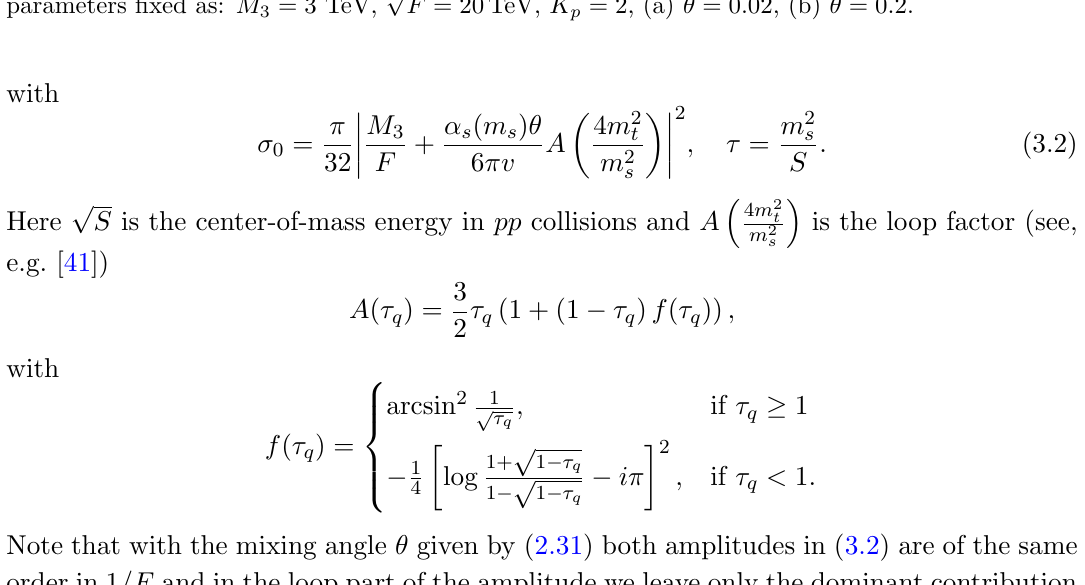
Figure 2. Sgoldstino production cross section for a set of total energies of protons p S , and model parameters (cid:12)xed as: M 3 = 3 TeV, p F = 20 TeV, K p = 2, (a) (cid:18) = 0 : 02, (b) (cid:18) = 0 :